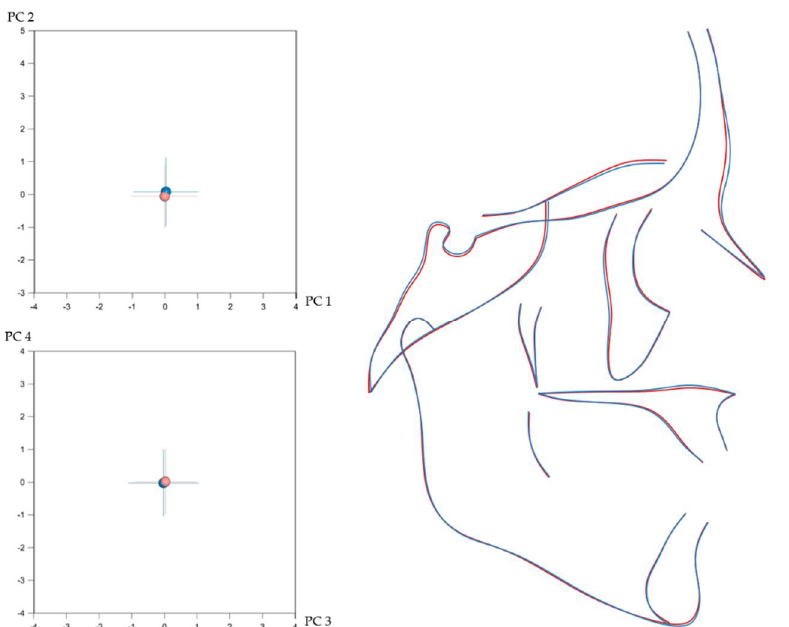
Figure 2. Left : Average difference between males (blue) and females (light red) in entire craniofacial configuration shape as explained by PC1 (21.8%)–PC2 (15.5%) ( top ) and PC3 (7.8%)–PC4 (6.2%) ( bottom ). The numbers in the parentheses represent the percentage of variation explained by each PC. Right : Best fit superimposition of average male (blue) and average female (light red) craniofacial configurations.